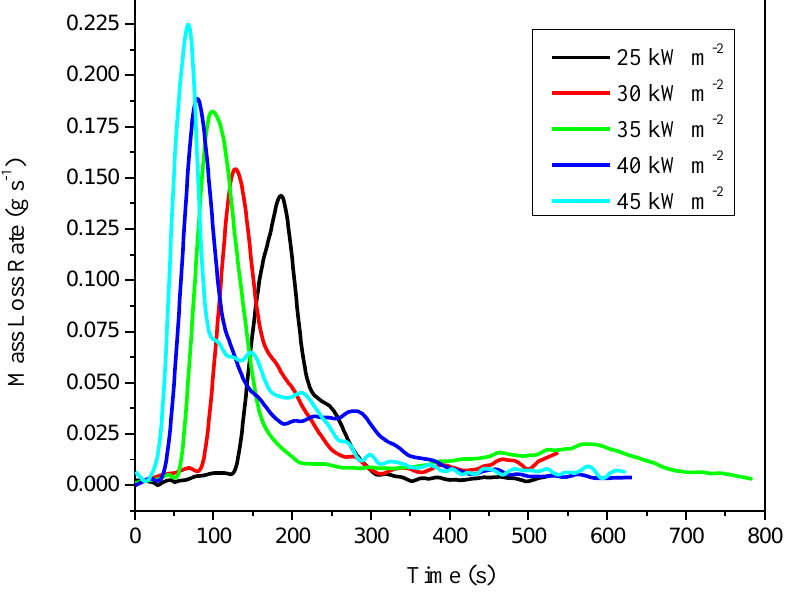
Figure 9. Mass loss rate (g s −1 ) as a function of experimental time(s).